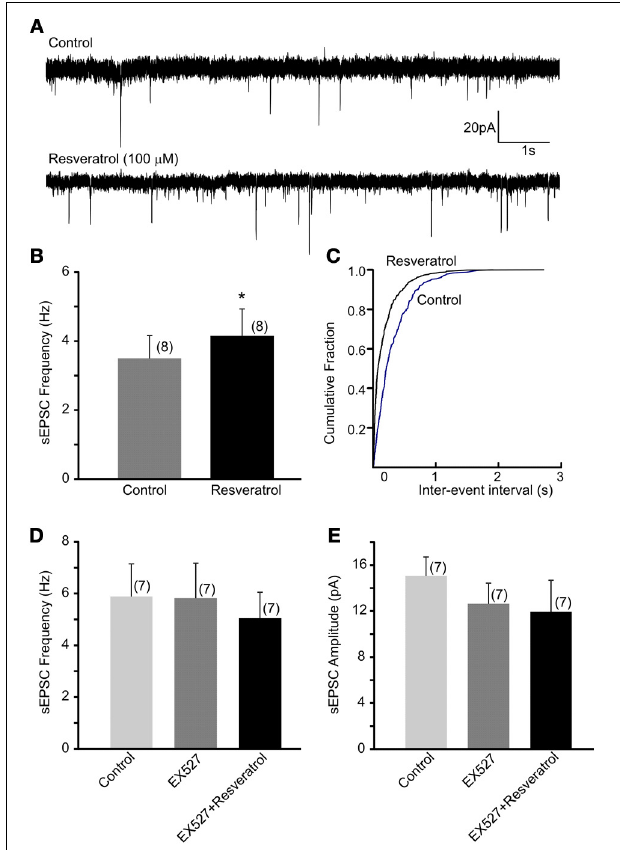
FIGURE 1 | Resveratrol increased spontaneous excitatory neurotransmission through SIRT1 activation in neurons of the dorsal motor nucleus of the vagus (DMV). (A) Continuous whole-cell patch-clamp recordings of spontaneous EPSCs (sEPSCs) at holding potential of − 60mV before (upper trace) and after (lower trace) resveratrol application. (B) Combined data showing increased frequency of sEPSCs following resveratrol application. ∗ Significance ( p < 0 . 05). (C) Cumulative event probability plot of inter-event interval distribution in the recording shown in (A) . (D) Mean group data showing that in the presence of a selective SIRT1 inhibitor EX527 resveratrol failed to increase sEPSC frequency in DMV neurons. (E) Combined data showing no significant change in amplitude of sEPSCs following resveratrol application in the presence of EX527.